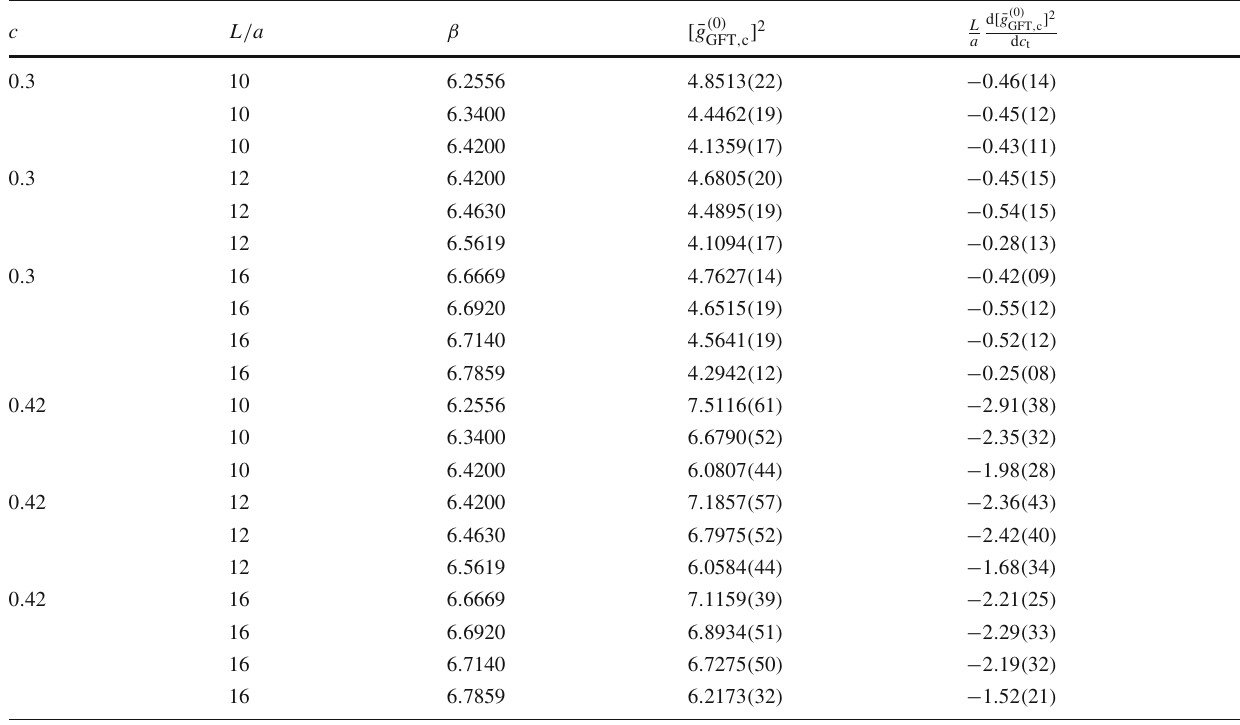
Table 5 Results for the (cid:22) c t → 0 extrapolations, Eq. (A.20), for dif- improved plaquette + clover definition of the flow energy density [52]. ( 0 ) ] 2 . The results refer to We considered linear extrapolations in ((cid:22) c t ) 2 using all available (cid:22) c t ferent values of L / a , c , and couplings [¯ g GFT , c the magnetic coupling discretized using the Zeuthen flow and O( a 2 )-